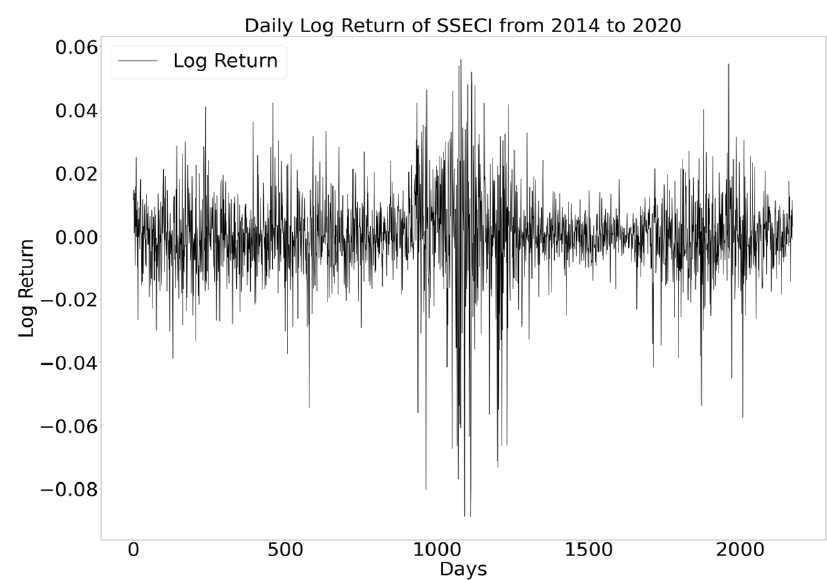
Figure 3. The graph of SSECI log return from 2014 to 2020.